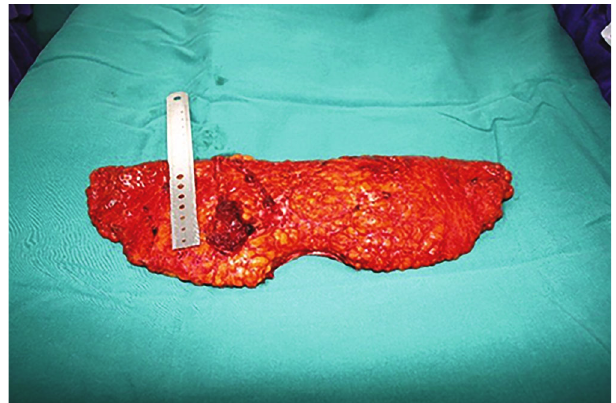
Figure 2: Example of 2 perforators for fl ap.